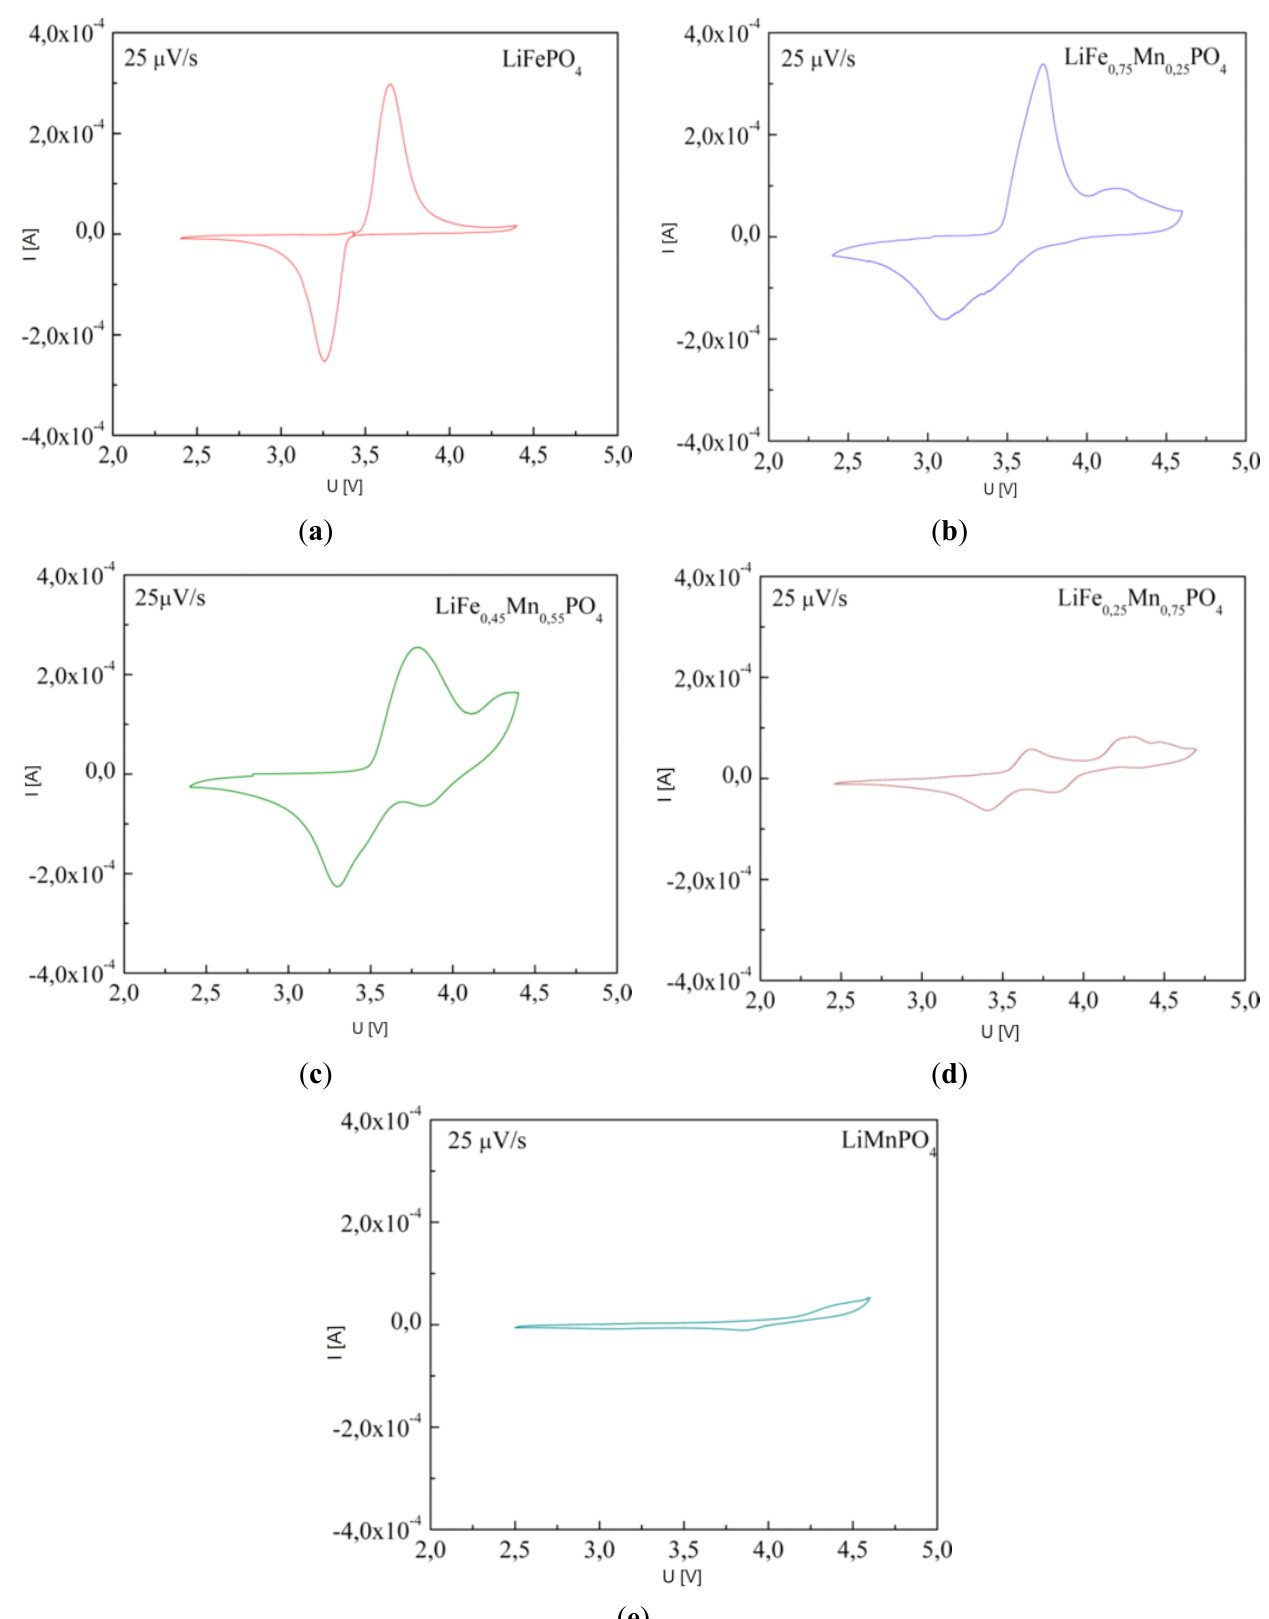
Figure 32. Cyclic voltammograms recorded for Li/Li + /Li material with different concentration of manganese: ( a ) y = 0; ( b ) y = 0.25; ( c ) y = 0.55; ( d ) y = 0.75 and ( e ) y = 1